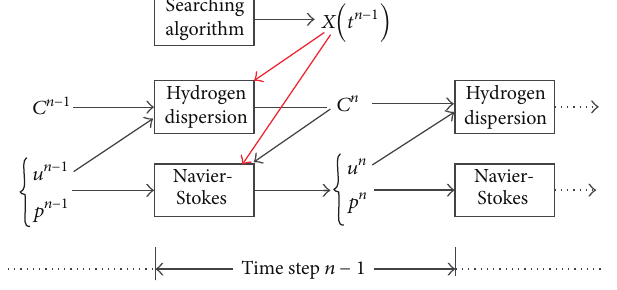
Figure 1: The coupling scheme.